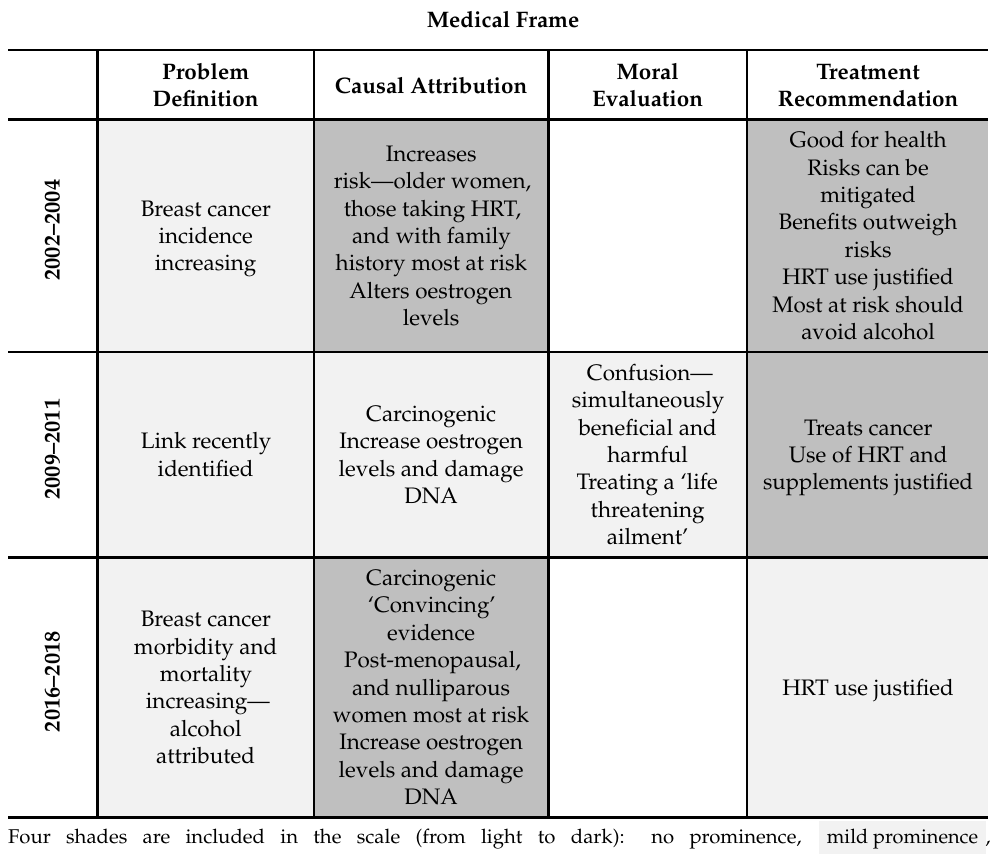
Table 1. Dominant medical frame